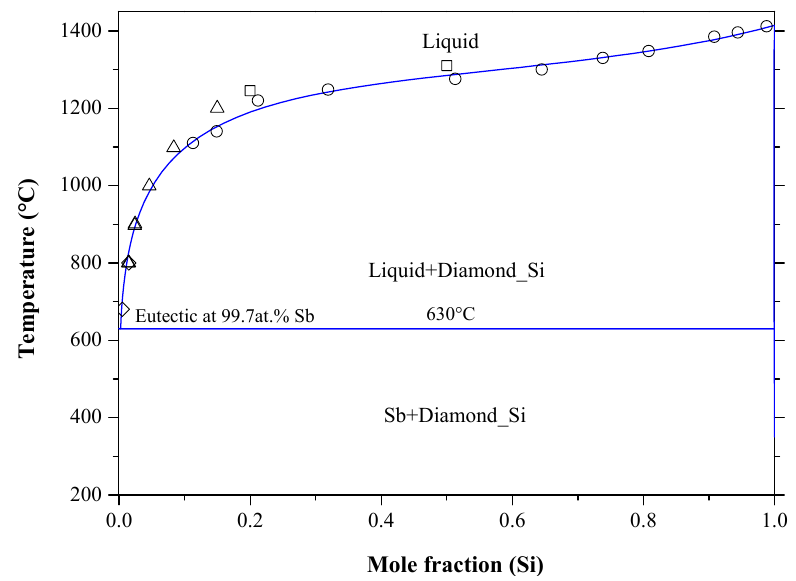
Figure 31. The calculated Sb-Si binary phase diagram by Wang et al. [277]; ○ : [177]; □ : [275]; Δ : [120]; : [178].